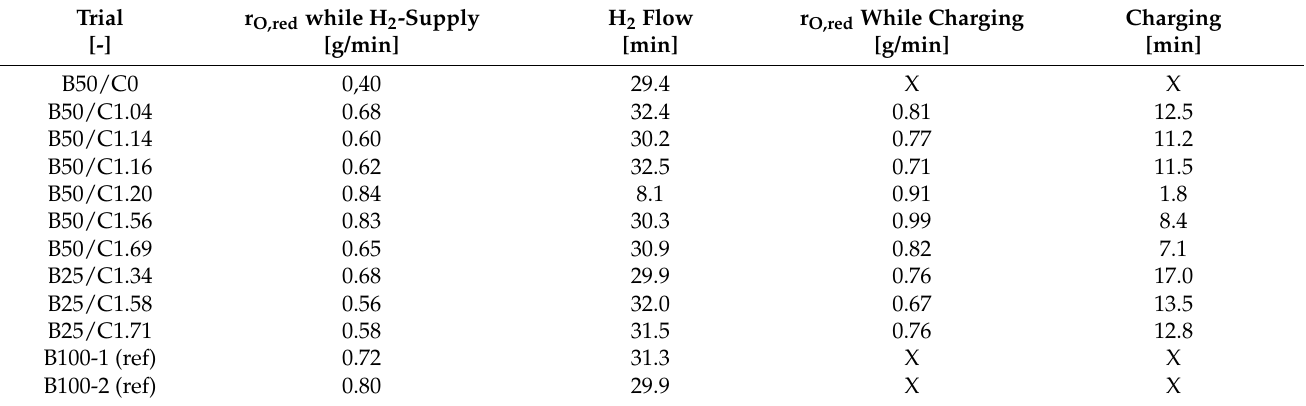
Figure 19. Comparison of the evaluated oxygen removal rates for the total trials (batch + charging) and for the time of charging. Table 8. Comparison of evaluated rates for oxygen removal of all conducted